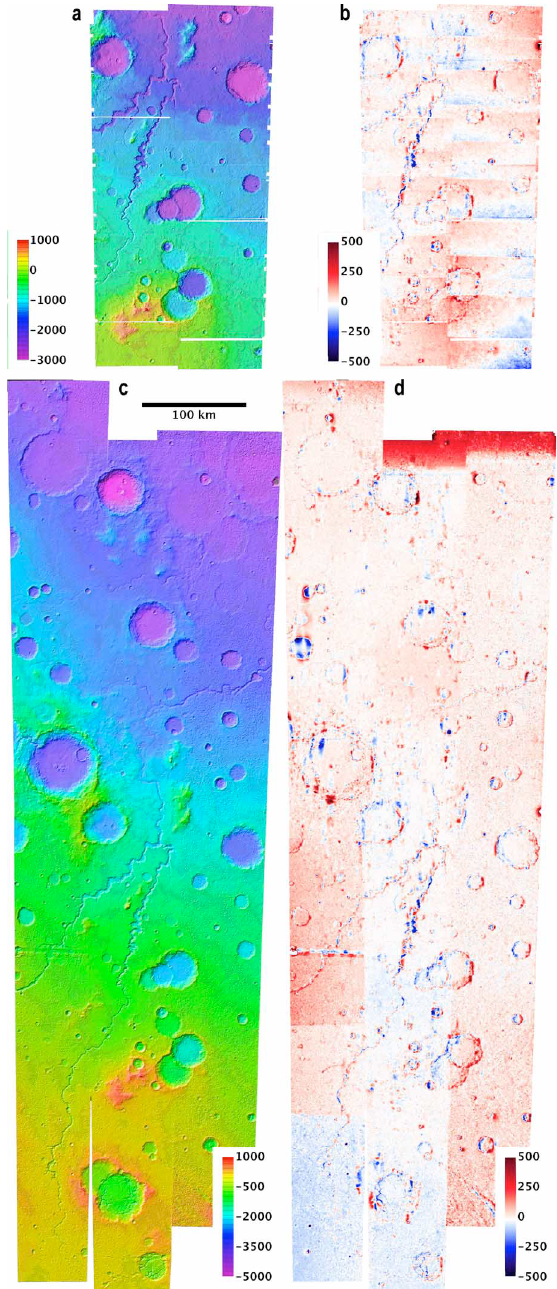
Figure 3. Nanedi comparison area. (a) Color shaded relief of area mapped in 2006. (b) Difference of 2006 DTM from MOLA, showing artifacts related to the segmentation of the images by exposure time. Note different color scale from Fig. 1d and f. (c) DTM covering the full longitude extent of 3 orbits, presented for the first time in this work. (d) Difference between current DTM and MOLA.